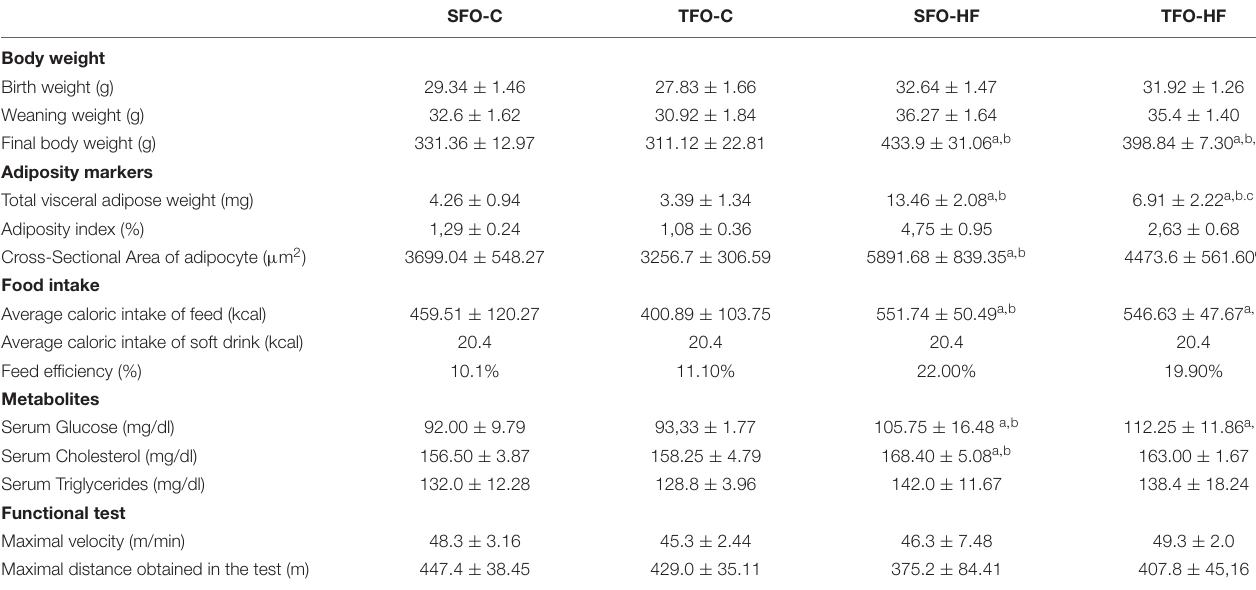
TABLE 1 | Growth trajectory of the